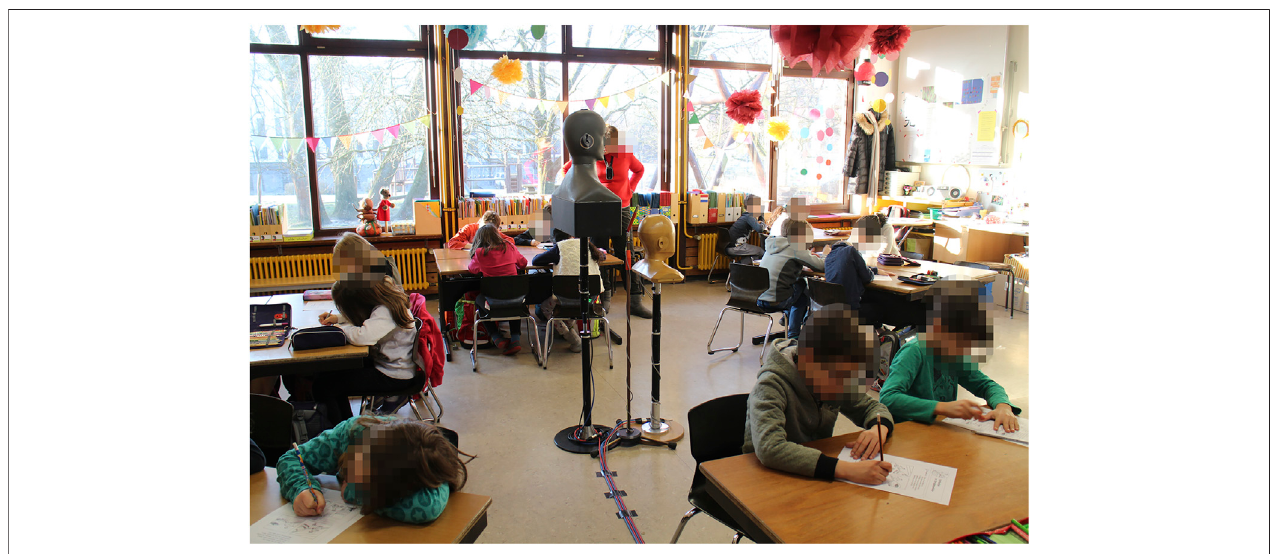
FIGURE 1 | Example of the centered positioning of the measurement transducers during an in-situ measurement in a classroom.